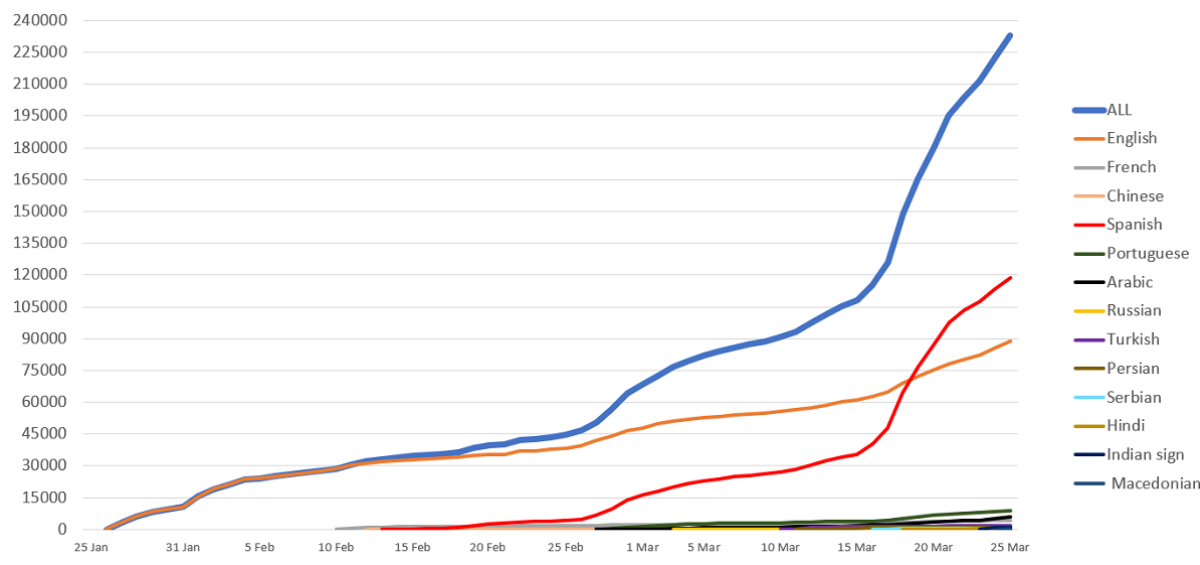
Figure 3. Introduction to coronavirus disease course use by language as of March 25, 2020.